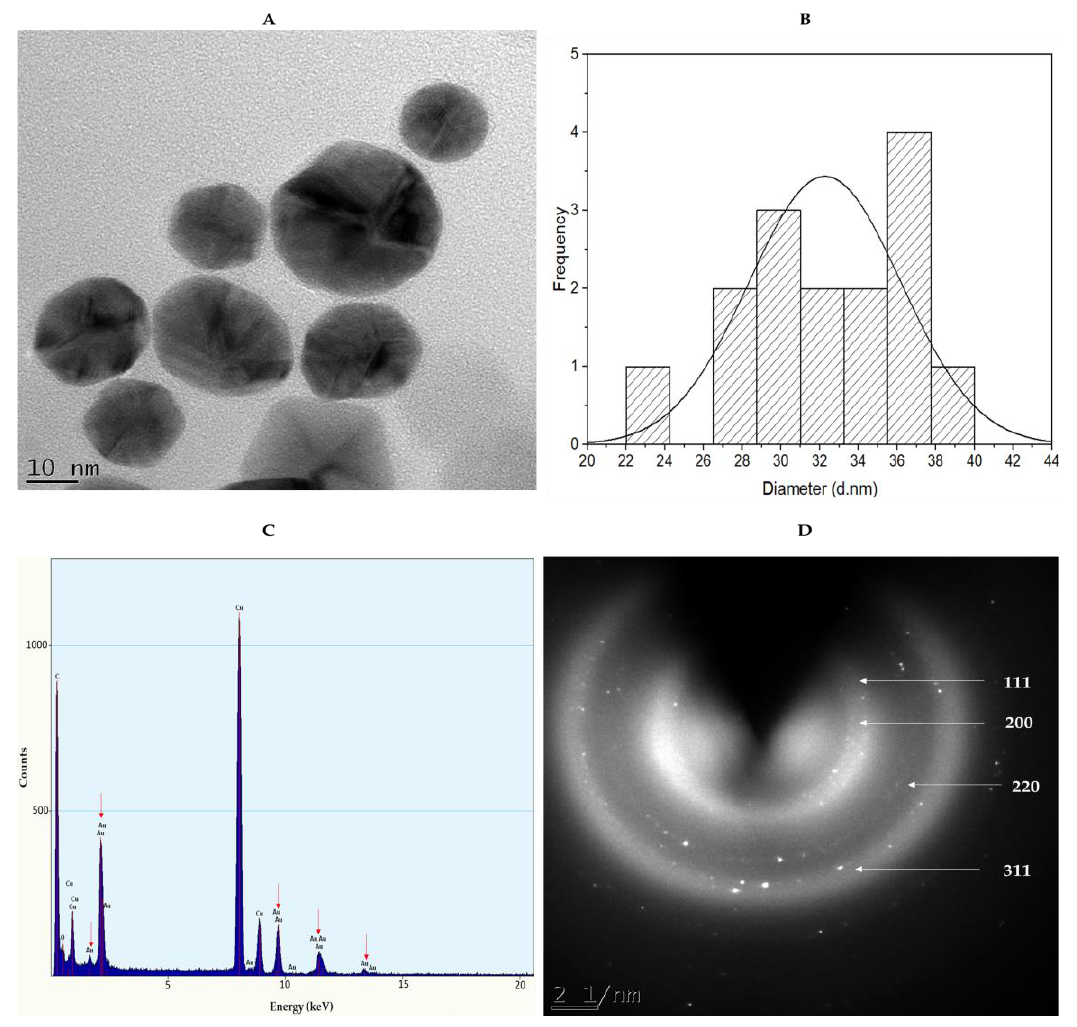
Figure 4. TEM micrograph ( A ), core size ( B ), EDX ( C ), and SAED patterns ( D ) of the 2 mg/mL_HB- AuNPs. Red arrows in the EDX show Au peaks.